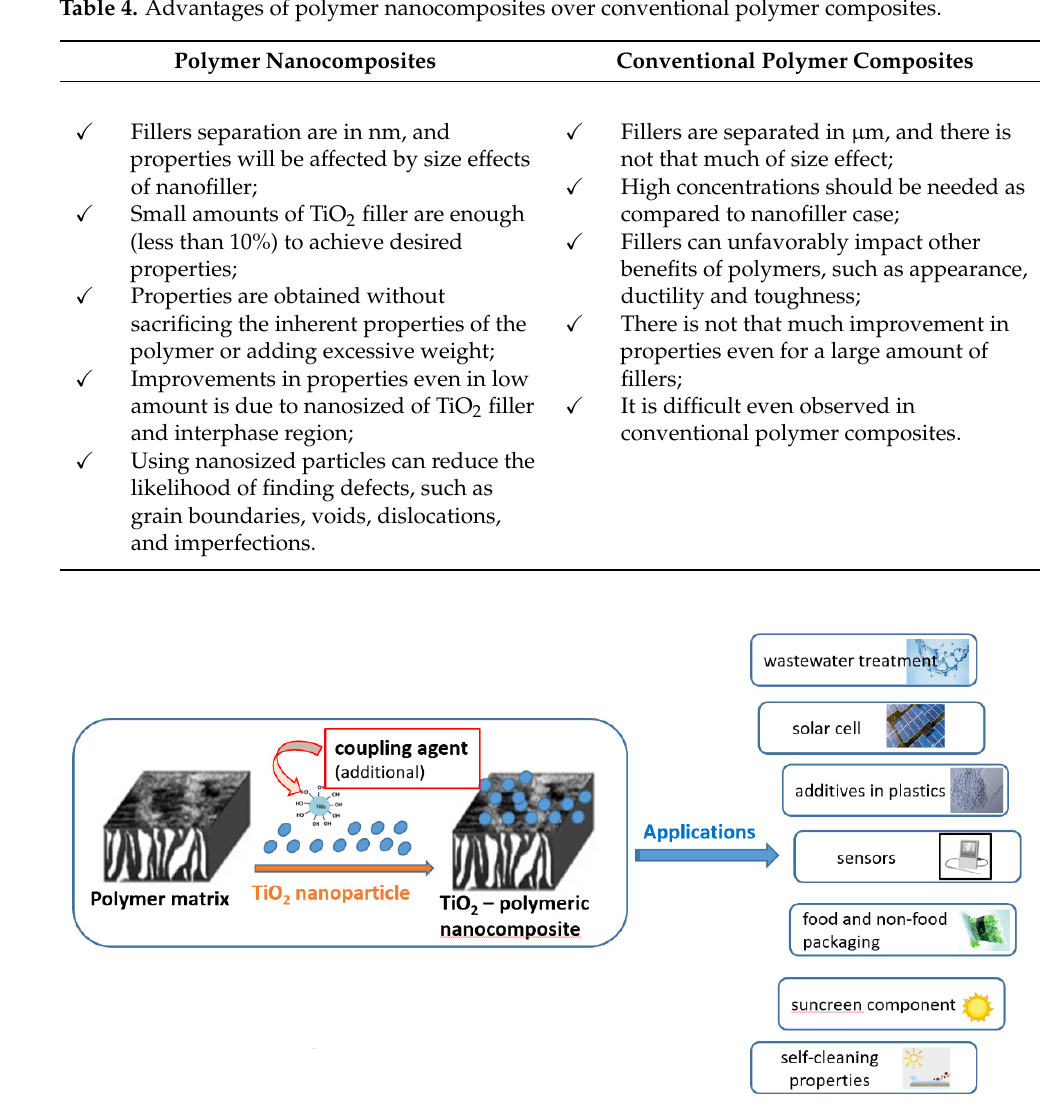
Figure 5. Applications of the TiO 2